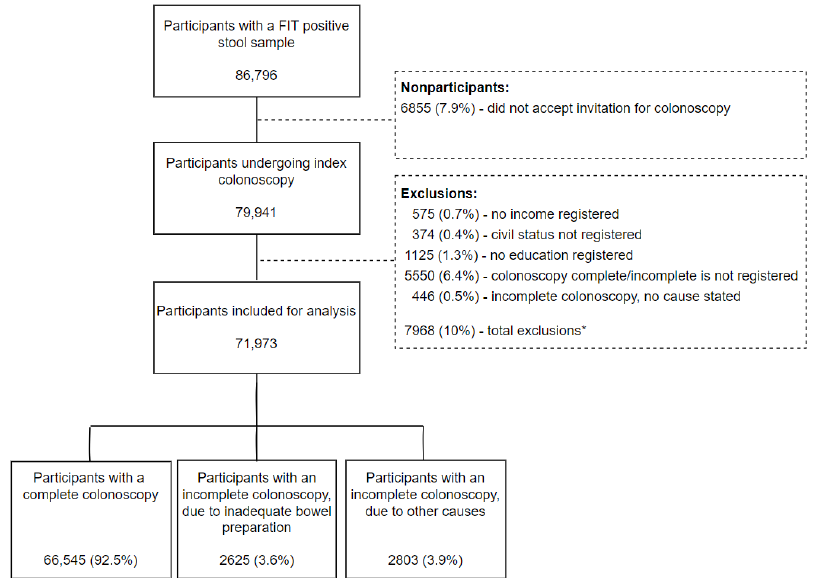
Figure 1. Flowchart of 86,796 first-round participants in the Danish Colorectal Cancer Screening Program with a positive FIT, of which 71,973 were eligible for further analysis. * Participants may be excluded in several variables. Table 1. Characteristics of the study population stratified by complete colonoscopy or incomplete colonoscopy due to inadequate bowel